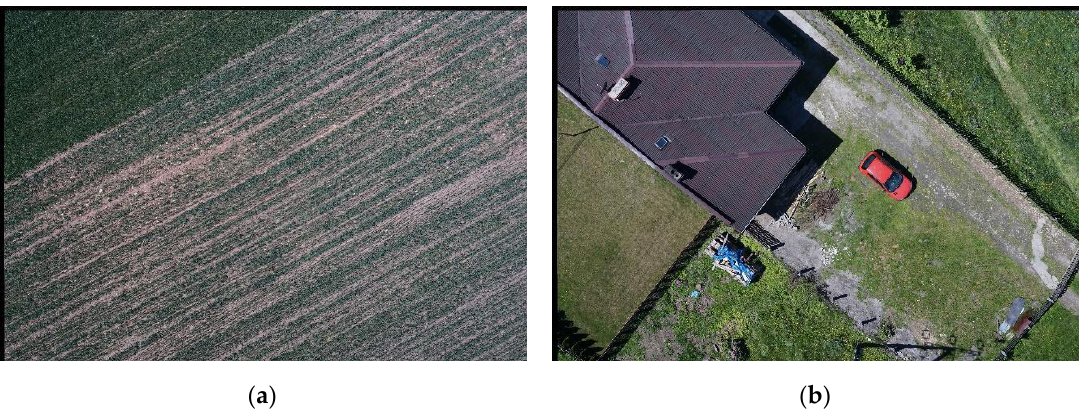
Figure A1. Sample images used for threshold sensitivity analysis: ( a ) ID 217, ( b ) ID 36.